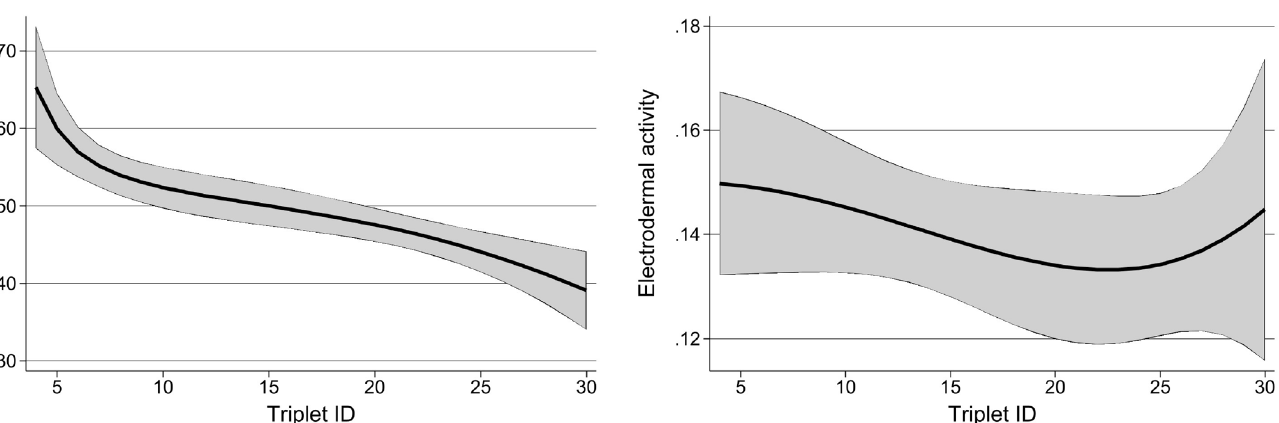
PLOS ONE | https://doi.org/10.1371/journal.pone.0254764 July 29,